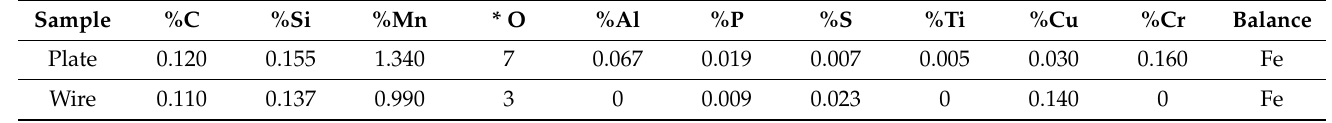
Table 1. Composition of steel base plate and weld wire used in welding